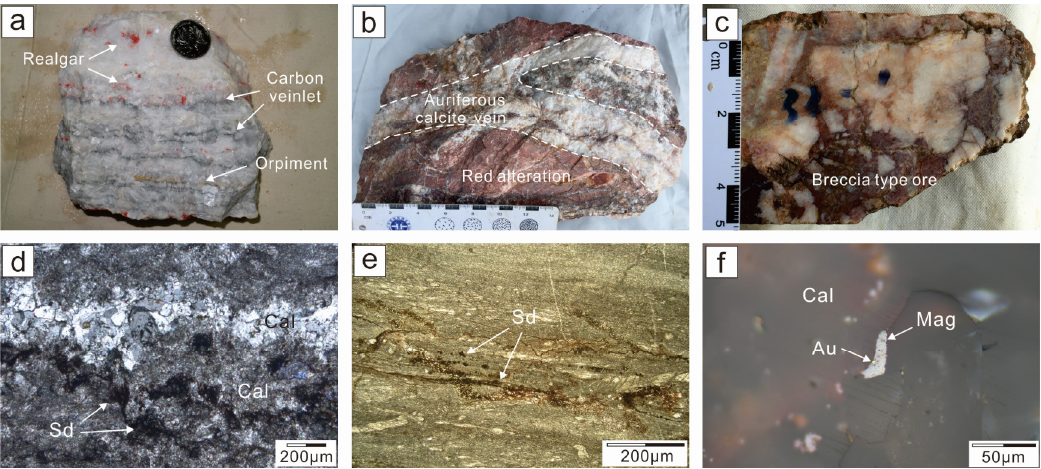
Figure 4. Hand samples and microscopic photographs of typical ores in Phapon gold deposit. ( a ) Auriferous calcite veins filled with dark-colored carbon layers and red alteration veinlets; ( b ) red alteration with calcite veinlets; ( c ) breccia type ore; ( d ) calcite veinlet in limestone; ( e ) visible siderite disseminated in limestone; ( f ) native gold together with magnetite appears as fine disseminations in calcite. Au, gold; Cal, calcite; Mag, magnetite; Sd, siderite. Mineral paragenesis and mineralization stages are difficult to define and remain controversial.